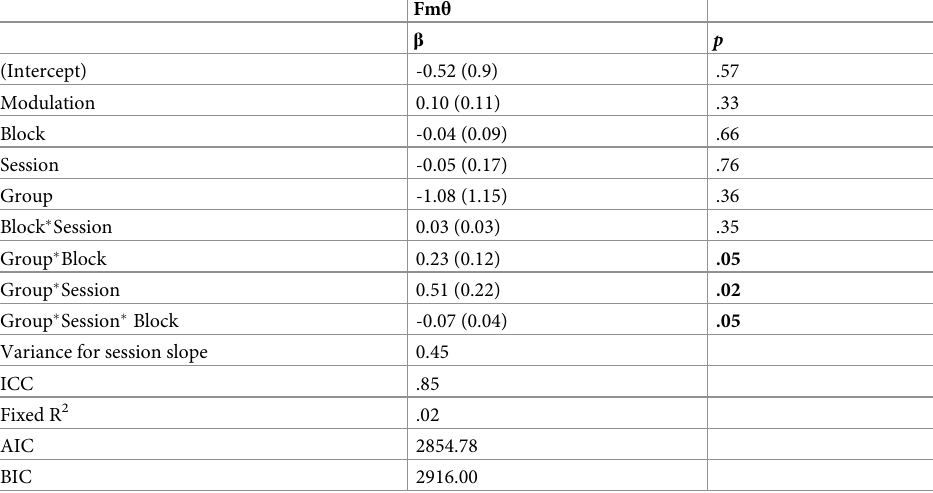
Table 1. Full MLM of Fm θ during NF